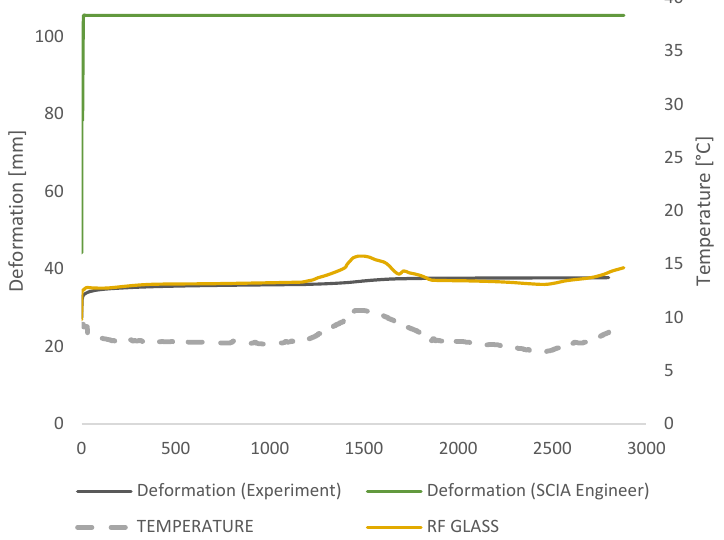
Figure 17. Deformation comparison from different software FEM analysis and measured data from the experiment. Thermo-rheological temperature dependence for time domain viscoelasticity was de- fined from the suboptions menu (TRS) inside of the material definition for the PVB inter- layer. Shift function approximation was defined as Williams–Landel–Ferry (WLF). Refer- ence temperature theta Θ was chosen at 50 °C as suggested by [14] and the WLF factors C 1s = 8.86 and C 2s = 101.6. Young modulus and Poisson’s ratio for the elastic properties of foil were selected for the exact time and temperature (1500 min and 39.4 °C). Interpolated elastic relaxation modulus was obtained from the Trosifol ® table E = 0.591 MPa and Pois- son’s ratio 0.495. The results are shown in Figure 18. Results fit the measurement data with almost 100% accuracy.